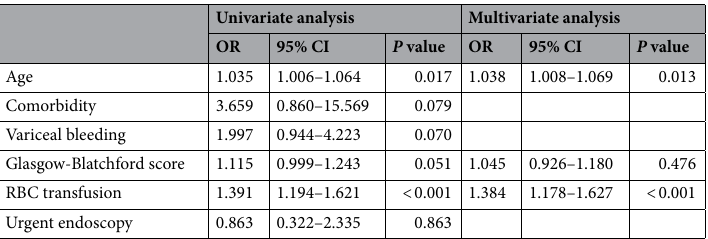
Table 3. Factors associated with mortality. BUN/Cr ratio ratio of blood urea nitrogen to creatinine, CI confidence interval, OR odds ratio, RBC red blood